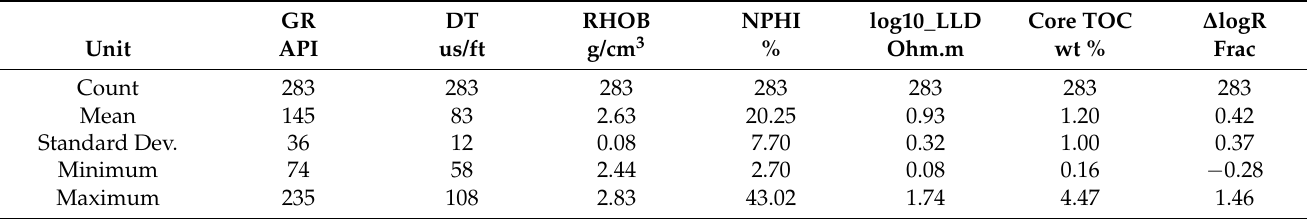
Table 3. Complete statistical analysis of input and output variables for TOC predictive modelling exercise. ∆ logR is computed from Passey’s overlay technique [26] described in Section